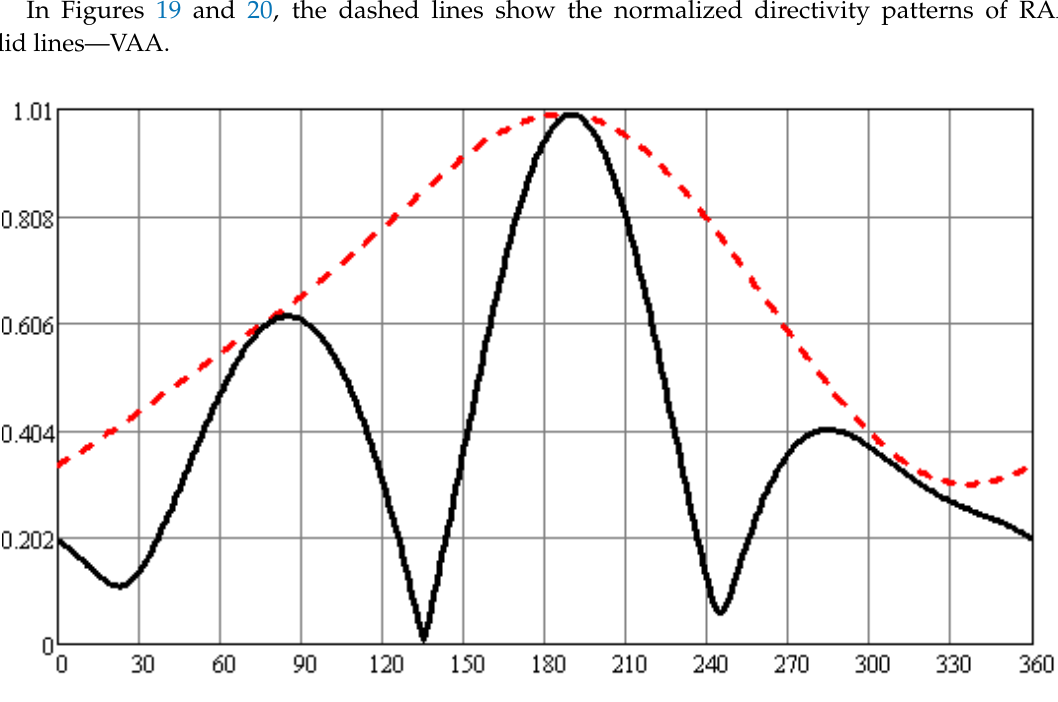
Figure 19. Azimuths of the sources— α 1 = 80 ◦ and α 2 = 180 ◦ ; VAA radius is 1.25 m; N = 72.